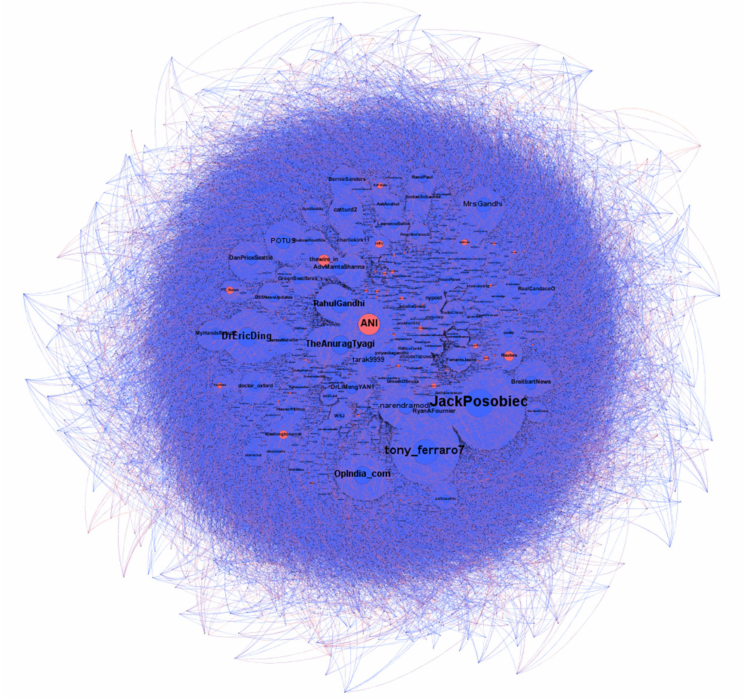
Figure 5. Twitter users’ retweet